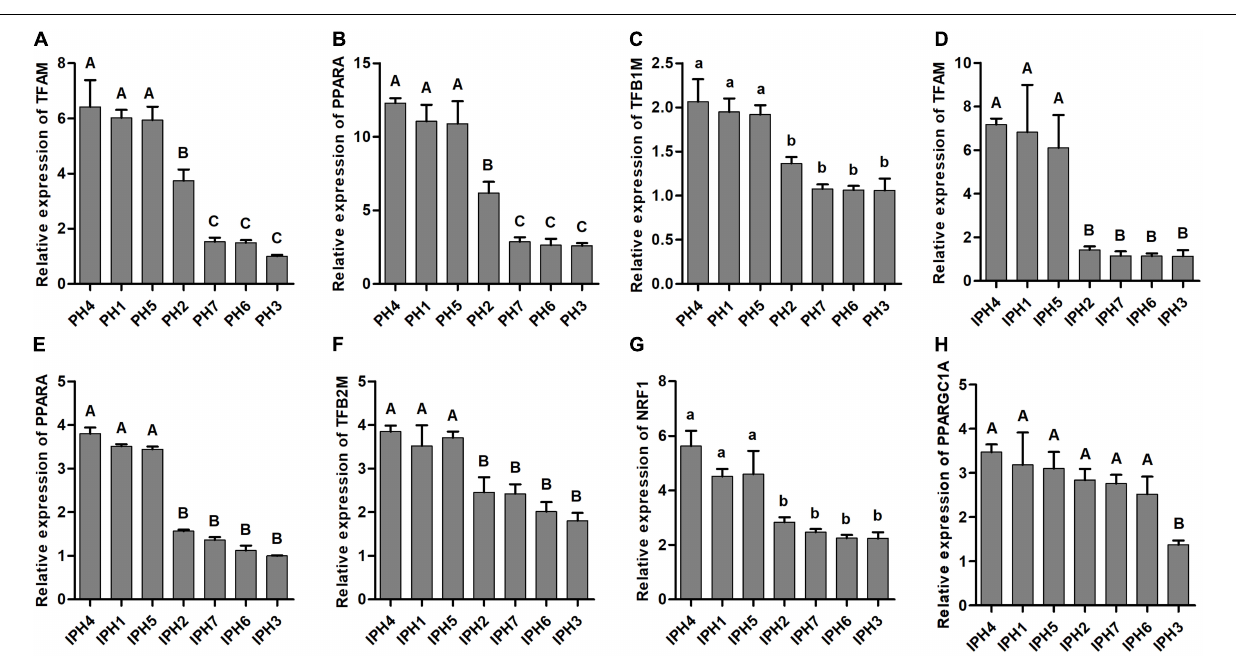
FIGURE 4 | mRNA expressions of mitochondrial biogenesis-related genes in fibroblasts and cybrids. (A–C) Illustrated the expressions of TFAM , TFB1M, and PPARA in fibroblasts, (D–H) presented the expressions of TFAM , TFB2M , PPARA , NRF1, and PPARGC1A in cybrids. Capital or lowercase letters on columns meant significant differences at P < 0.01 or P < 0.05 levels, respectively. PH1-7, fibroblast with mitotype 1–7, respectively; IPH1-7, cybrid with mitotype 1–7,